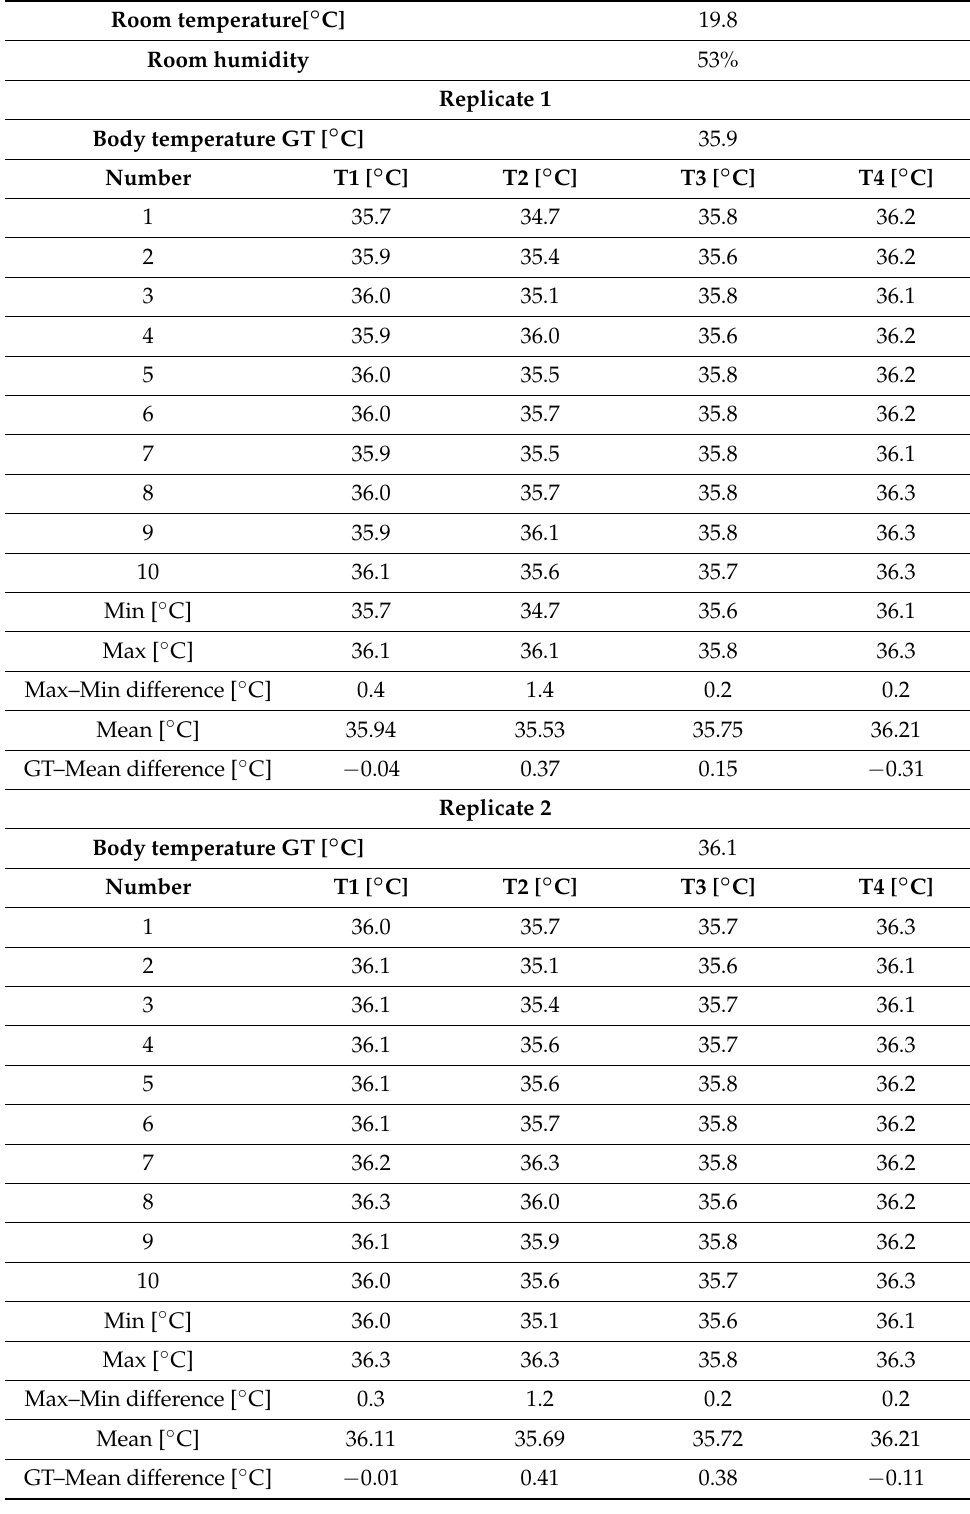
Table A2. Intra- and inter-rater reliability experiment. Subject 2 body temperature